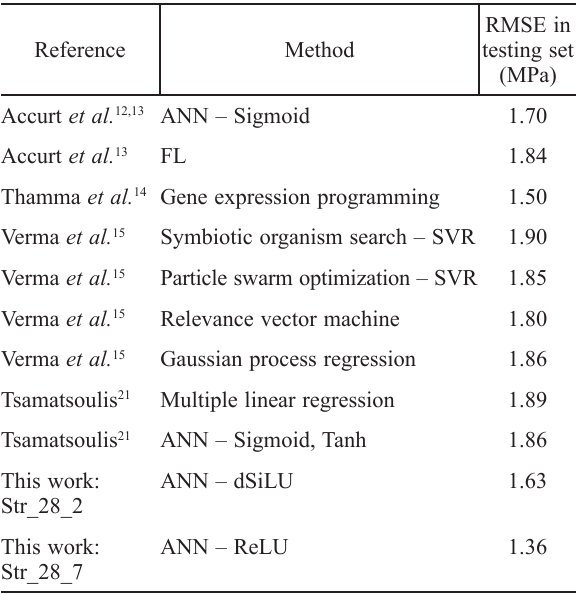
Table 8 – Comparison with literature